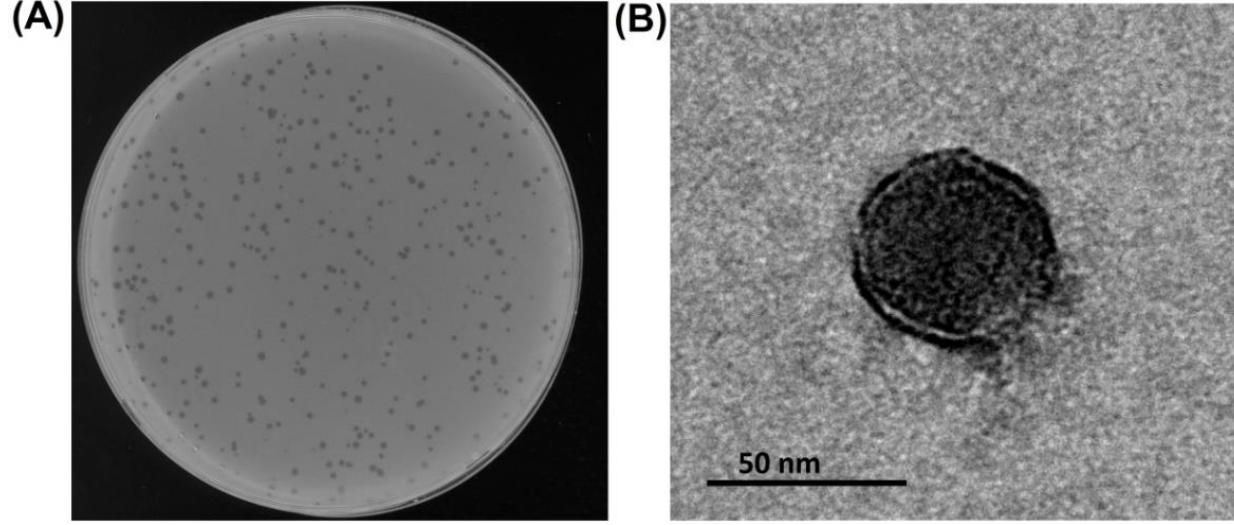
Figure 1. Morphological characteristics of phage Aristophanes. ( A ) Phage plaques on A. baumannii KZ1098. ( B ) Transmission electron micrographs of the phage particles. Staining with 1% uranyl acetate. The scale bar is 50 nm.